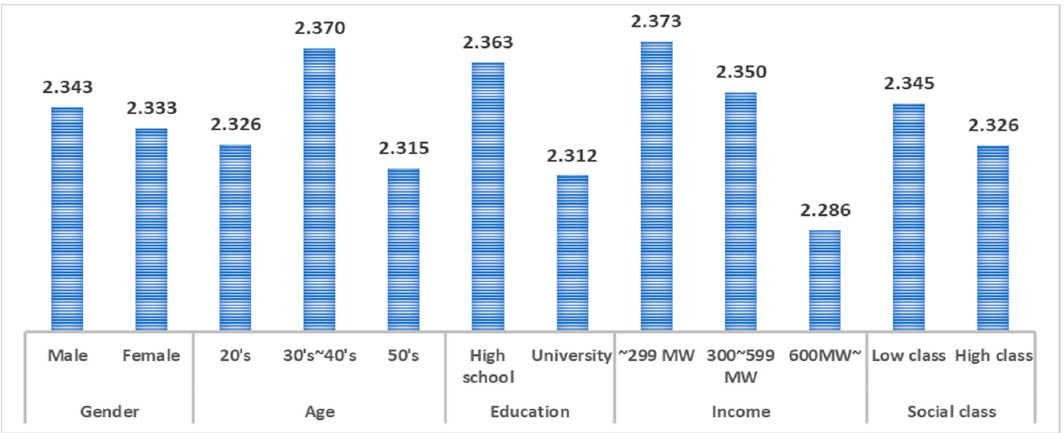
Figure 3. Mean by sociodemographic variables.